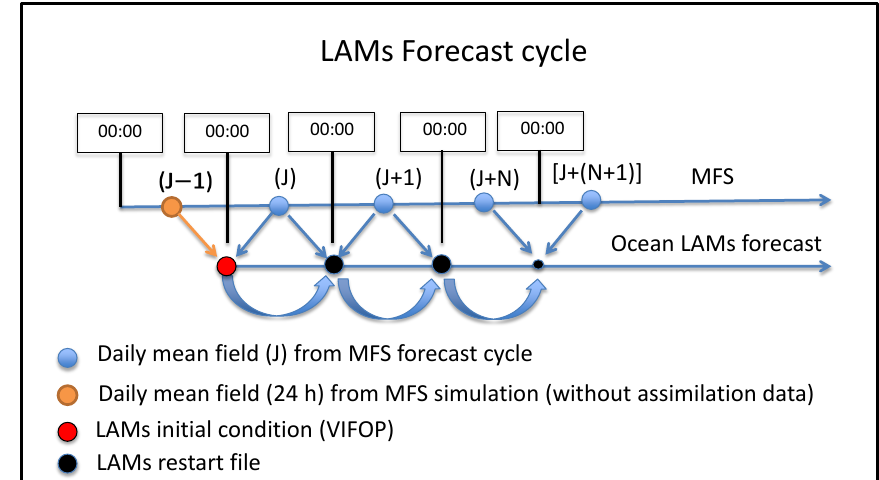
Figure 3. Every day (J) the ocean LAMs are initialized at midnight (the red circle) by variational initialization technique (VIFOP) using the simulation field (daily mean at J − 1, the orange circle) and the first forecast field (daily mean at J, the blue circle) from Mediterranean Forecasting System (MFS). These fields are centred at noon. The LAMs forecast is up to N ( = 5) days with output daily mean (centred at noon) and hourly (centred at